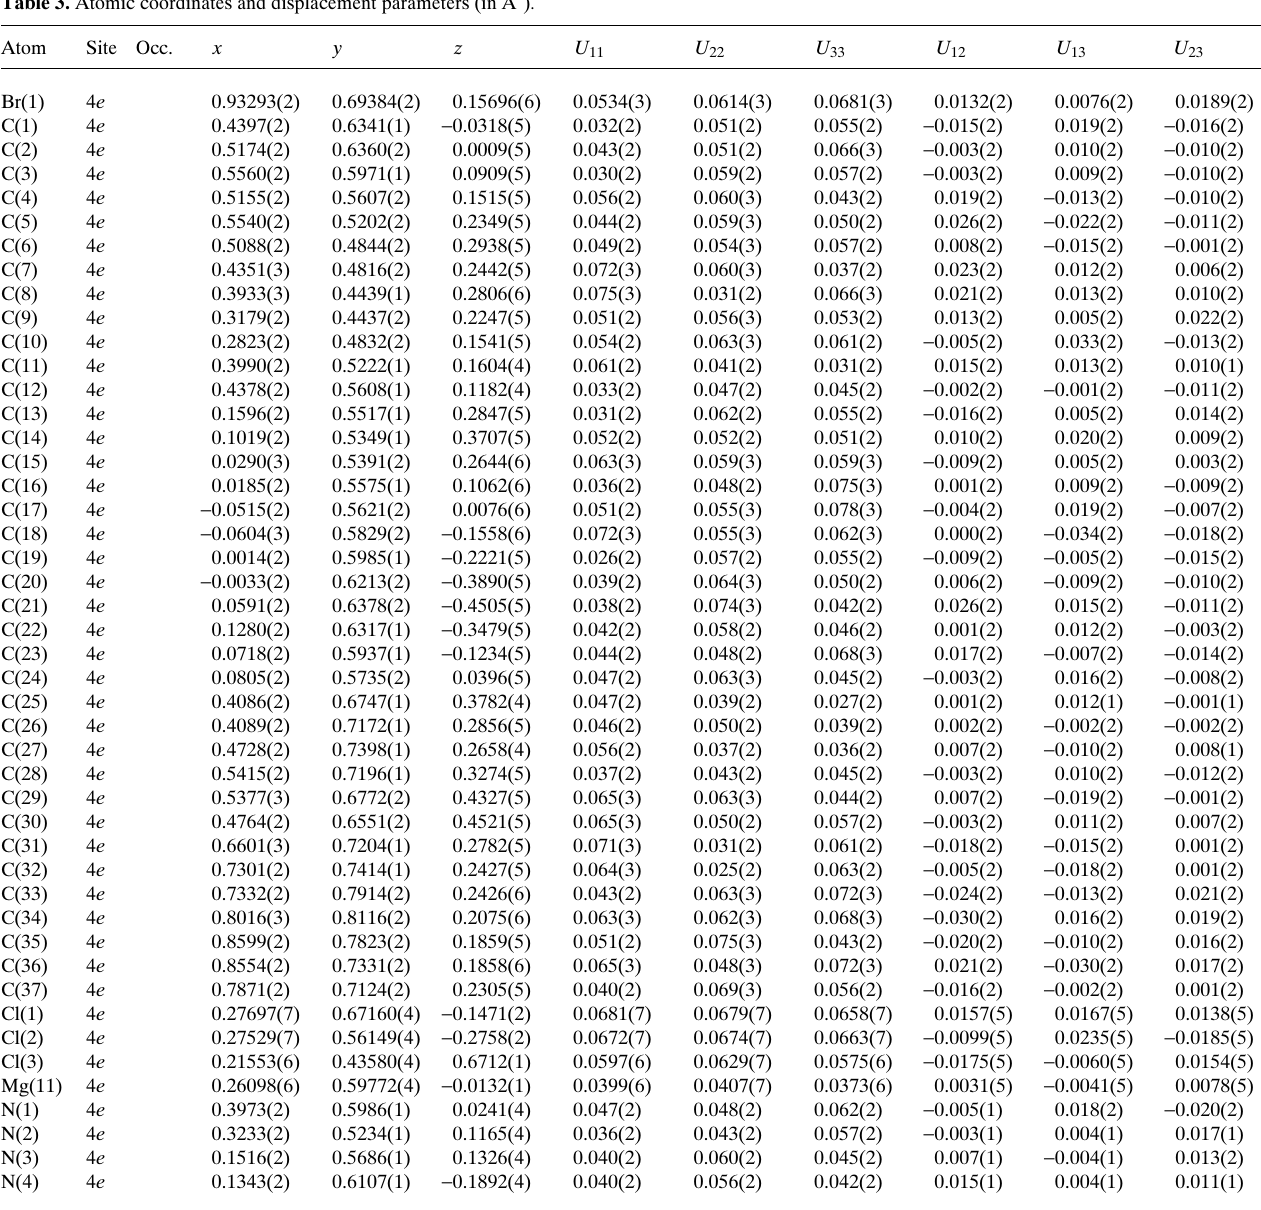
Table 3. Atomic coordinates and displacement parameters (in Å 2 ) .